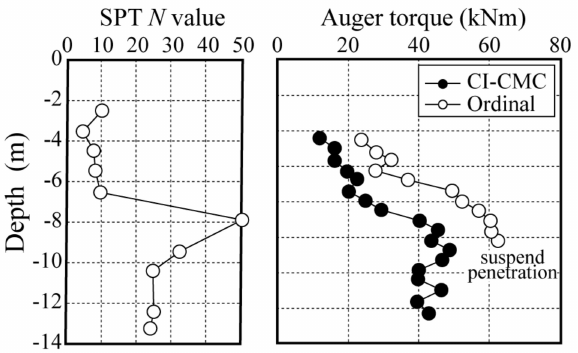
Figure 12. Effect of atomized cement slurry injection on penetration in the hard layer